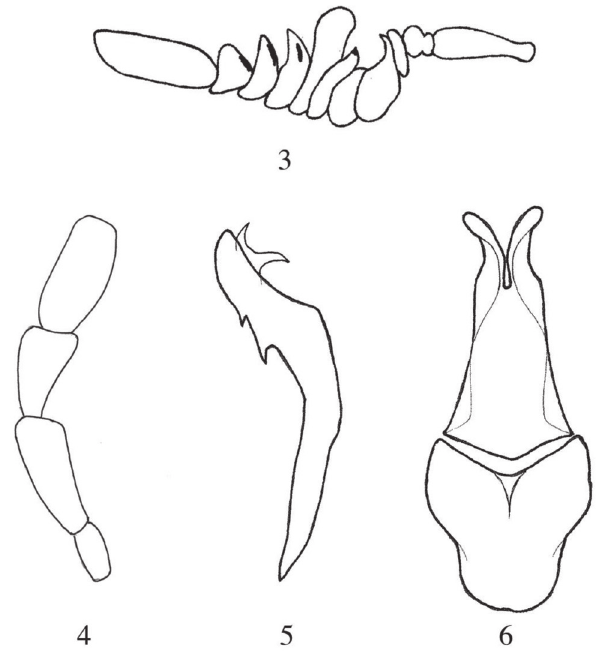
Figures 3–6. Diphorocera neglecta sp. n., 3 male antenna 4 male maxillary palpomeri 5 male aedeagus in lateral view 6 gonoforceps and gonocoxal piece in ventral